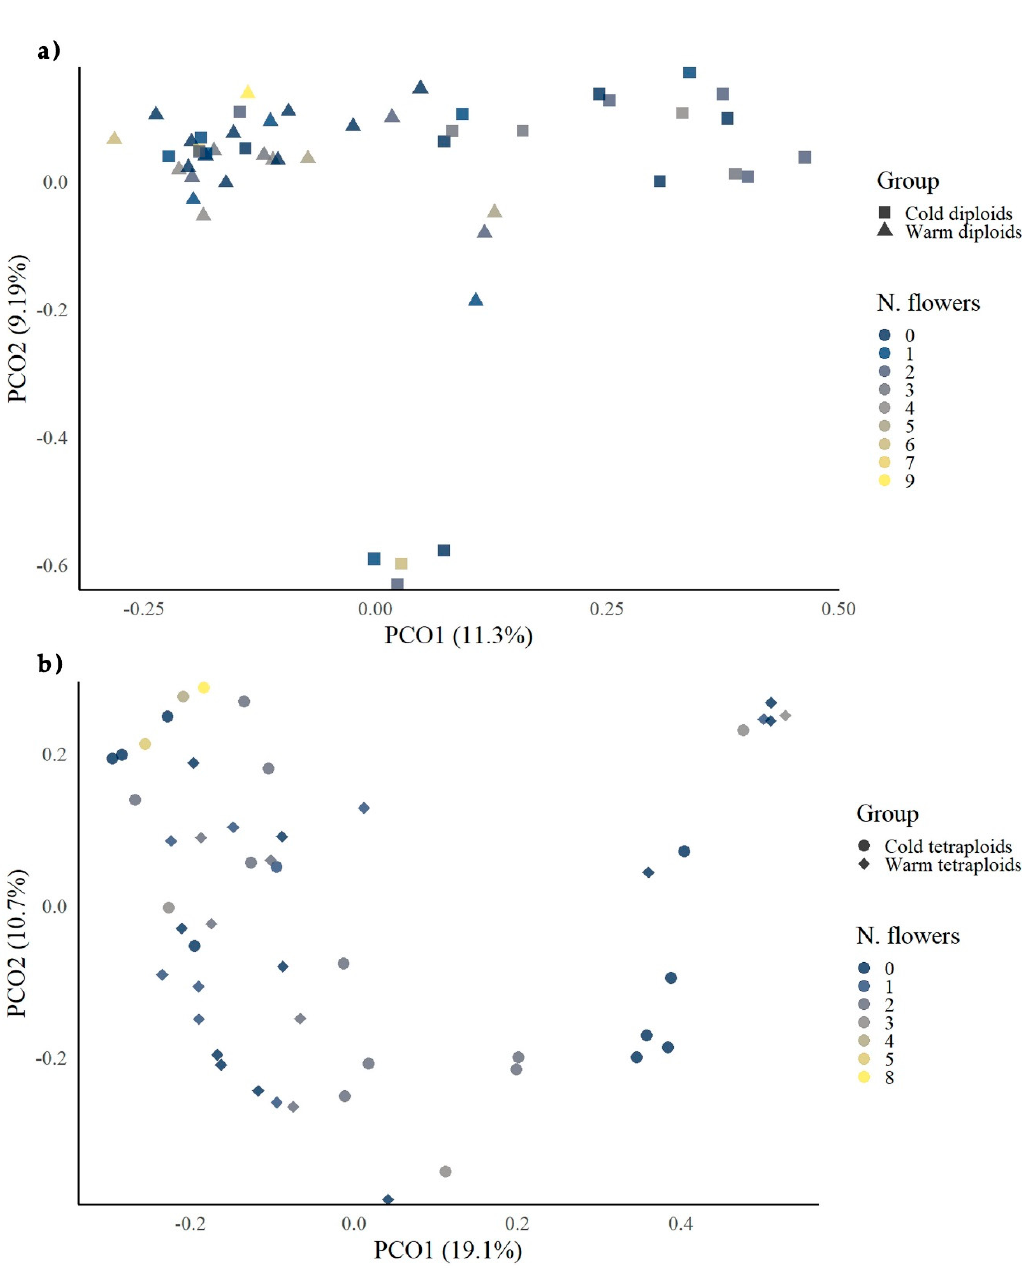
Figure 3. PCoAs of DNA methylation-sensitive amplified fragment-length polymorphisms (MS-AFLPs) against the number of flowers on treatment level of Ranunculus kuepferi diploid and tetraploid individuals: ( a ) diploid plants; ( b ) tetraploid plants.